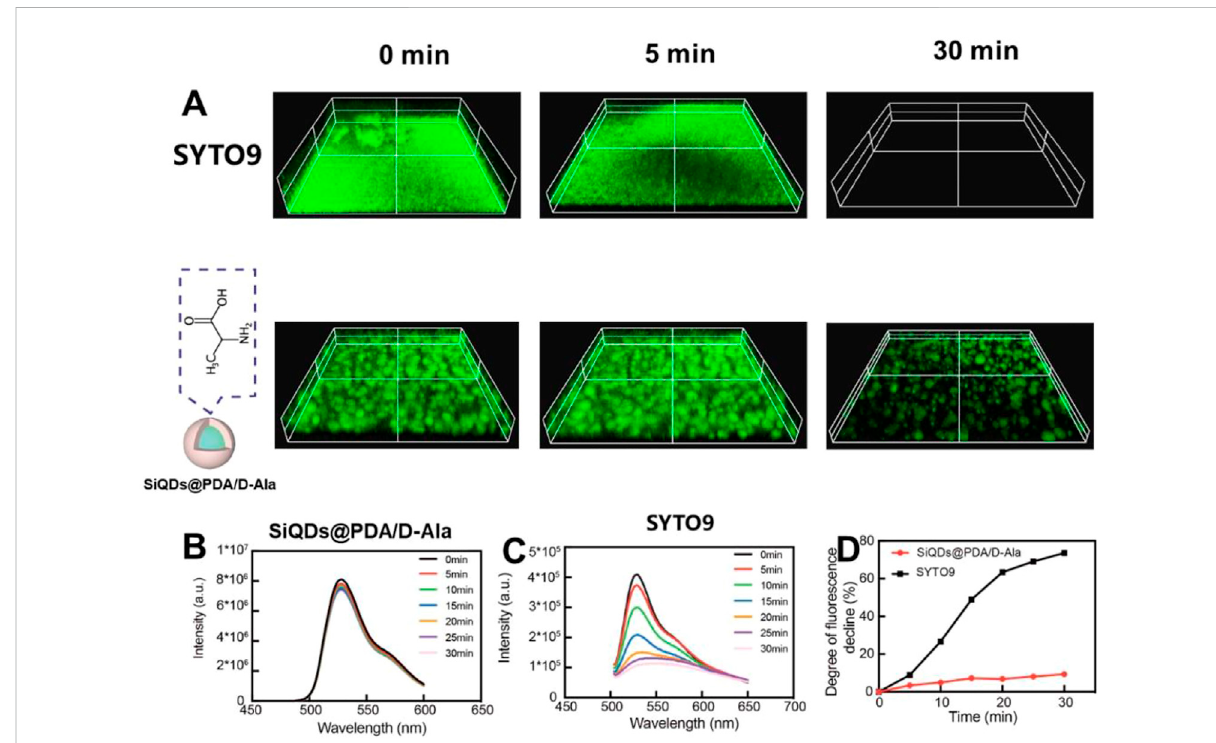
FIGURE 5 Anti-photobleaching characterizations. (A) Fluorescent images of SYTO 9 and SiQDs@PDA/D-Ala in S. aureus bio fi lm under white light irradiation; (B) fl uorescentintensityofSiQDs@PDA/D-Alaunderwhitelightirradiationovertime; (C) fl uorescentintensityofSYTO9underwhitelight irradiation over time; and (D) degree of fl uorescent intensity decline of SiQDs@PDA/D-Ala and SYTO 9 under white light irradiation over time. The power of light is 2